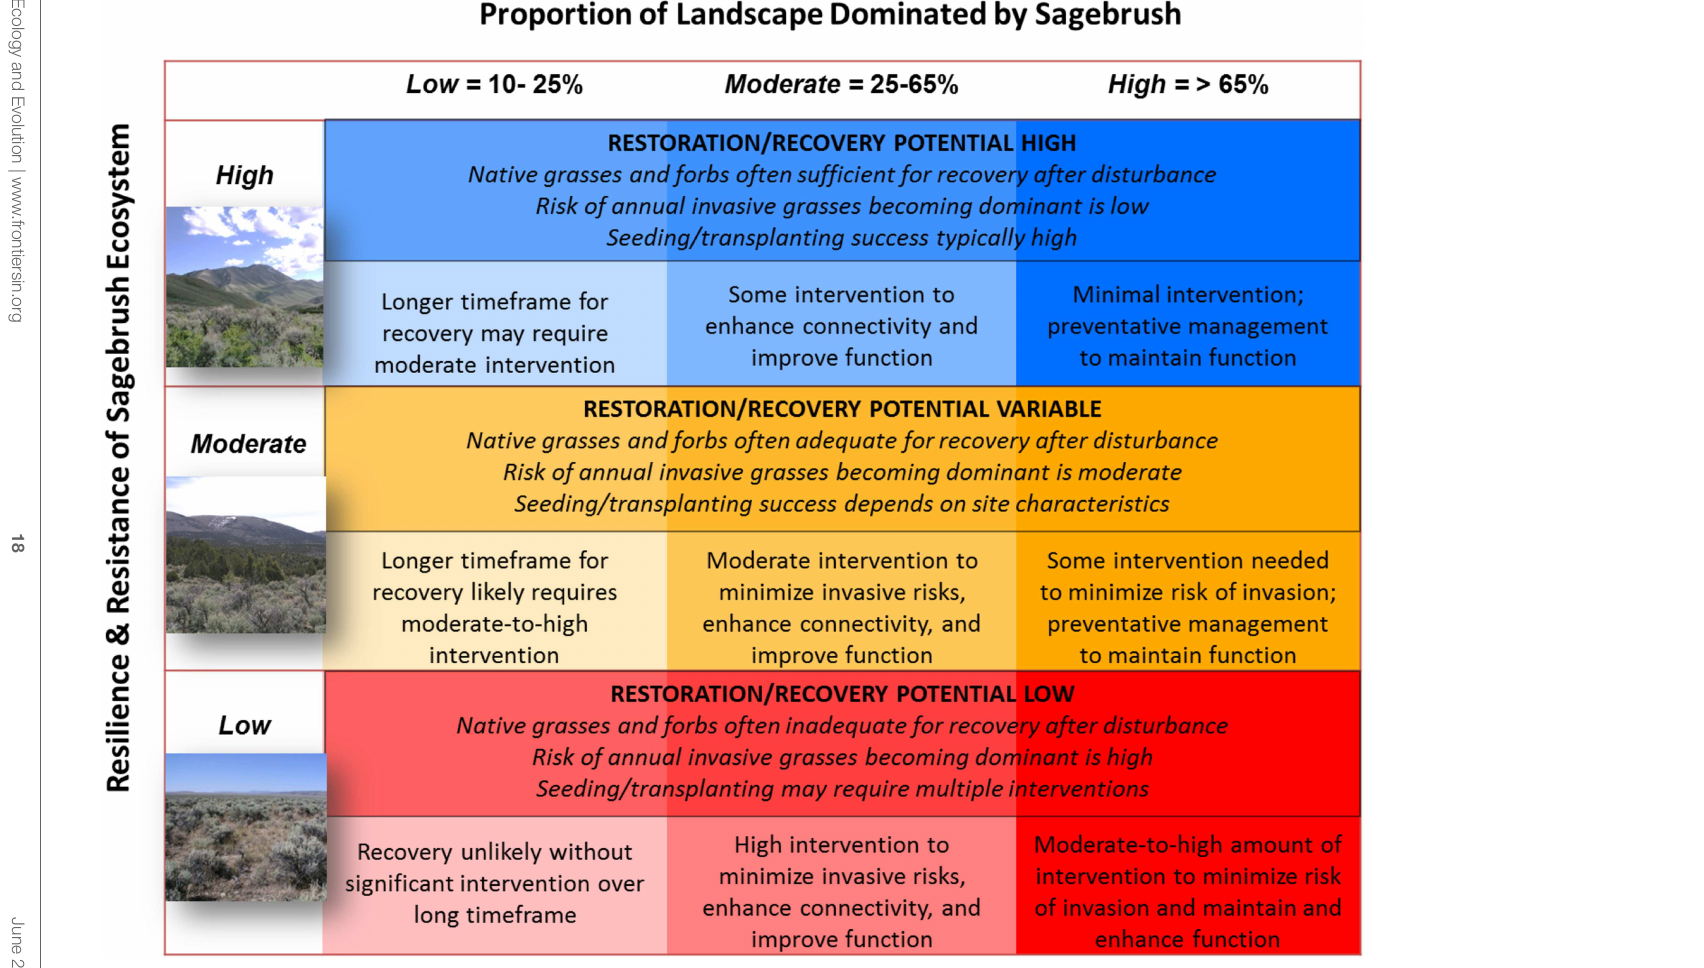
TABLE 3 | Decision matrix for prioritizing areas for conservation and restoration investments and determining appropriate management strategies based on resilience concepts (Chambers et al., 2014a, 2017a) 1 .